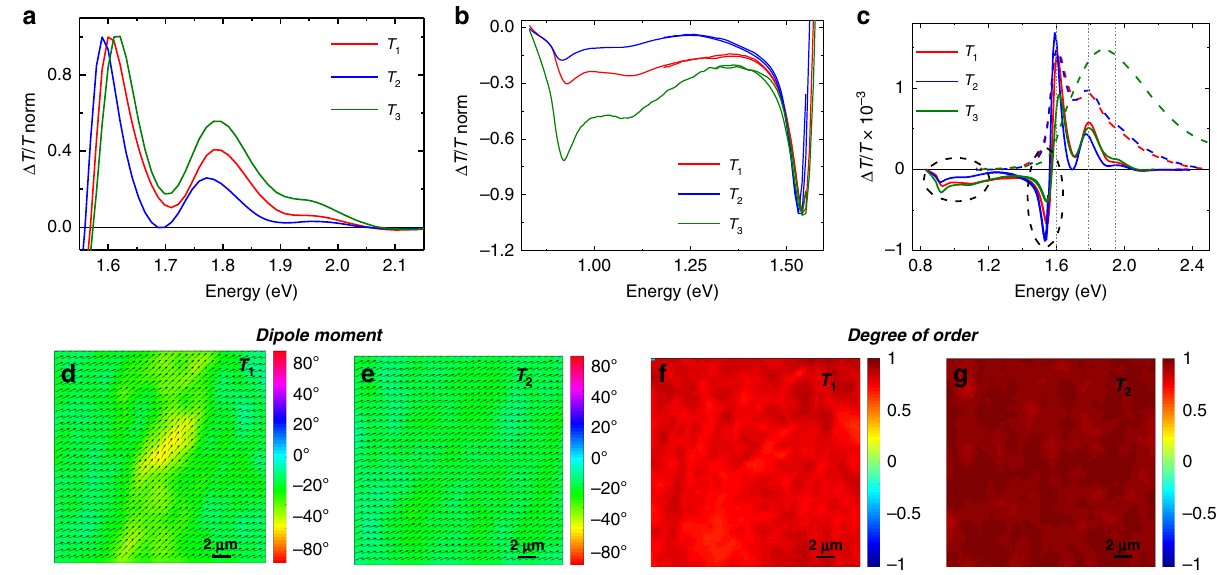
Fig. 8 Charge modulation micro-spectroscopy. Normalized CMS spectra of PThDPPThF4 in the high energy range (from 1.7 to 2.15 eV) ( a) and low-energy range (from 0.5 to 1.55 eV) ( b ); c CMS spectra of PThDPPThF4 annealed at T 1 , T 2 and T 3 , driven at V GS = 20 V; normalized optical density spectra (dashed lines) are also reported; 20 × 20 µ m 2 polarized CMM maps with the indication of the polymers backbone orientation ( d , e ) and the relative degree of orientational order ( f , g ) of PThDPPThF4 fi lms annealed at T 1 ( d , f ), and T 2 ( e , g